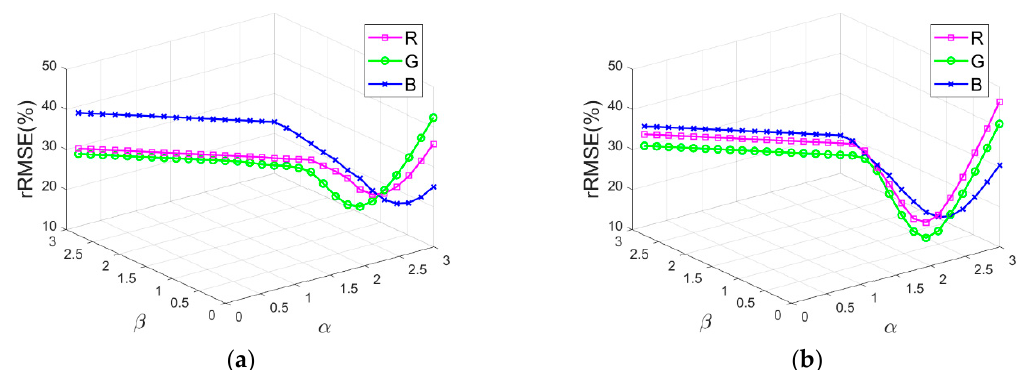
Figure 13. rRMSE of shadow compensation results with various α and β values for test images. ( a ) Tripoli-1. ( b ) Tripoli-2.